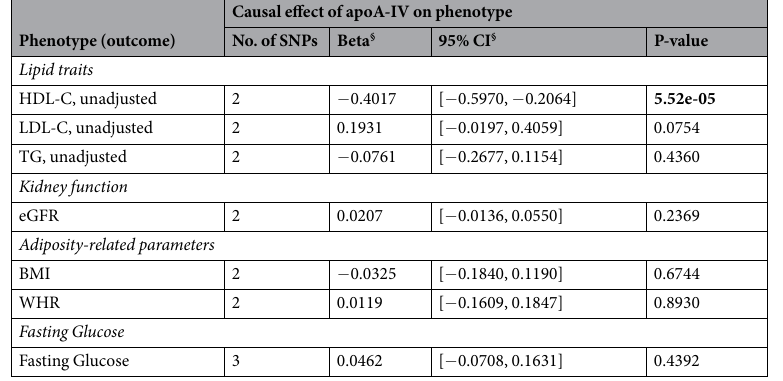
Table 4. MR-IVW estimates for all phenotypes assumed to be causally affected by apoA-IV concentrations. § In SD per change in log(apoA-IV) for the lipid and obesity traits, in log(eGFR) per change in log(apoA-IV) for kidney function, in mmol/L per change in log(apoA-IV) for fasting glucose. Here, apoA-IV acts as exposure and the phenotypes as the outcome traits. A p-value smaller than 0.05/8 = 0.00625 is considered to be significant (marked in